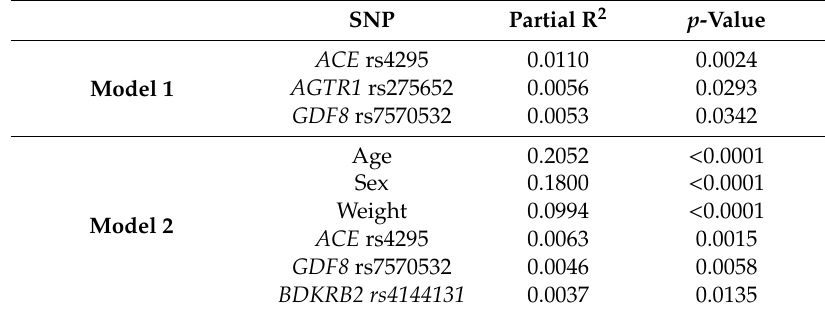
Table 3. List of single nucleotide polymorphisms associated with peak oxygen uptake in the study participants. Model 1, with genetic-only influence; model 2 with covariates. SNP Partial R 2